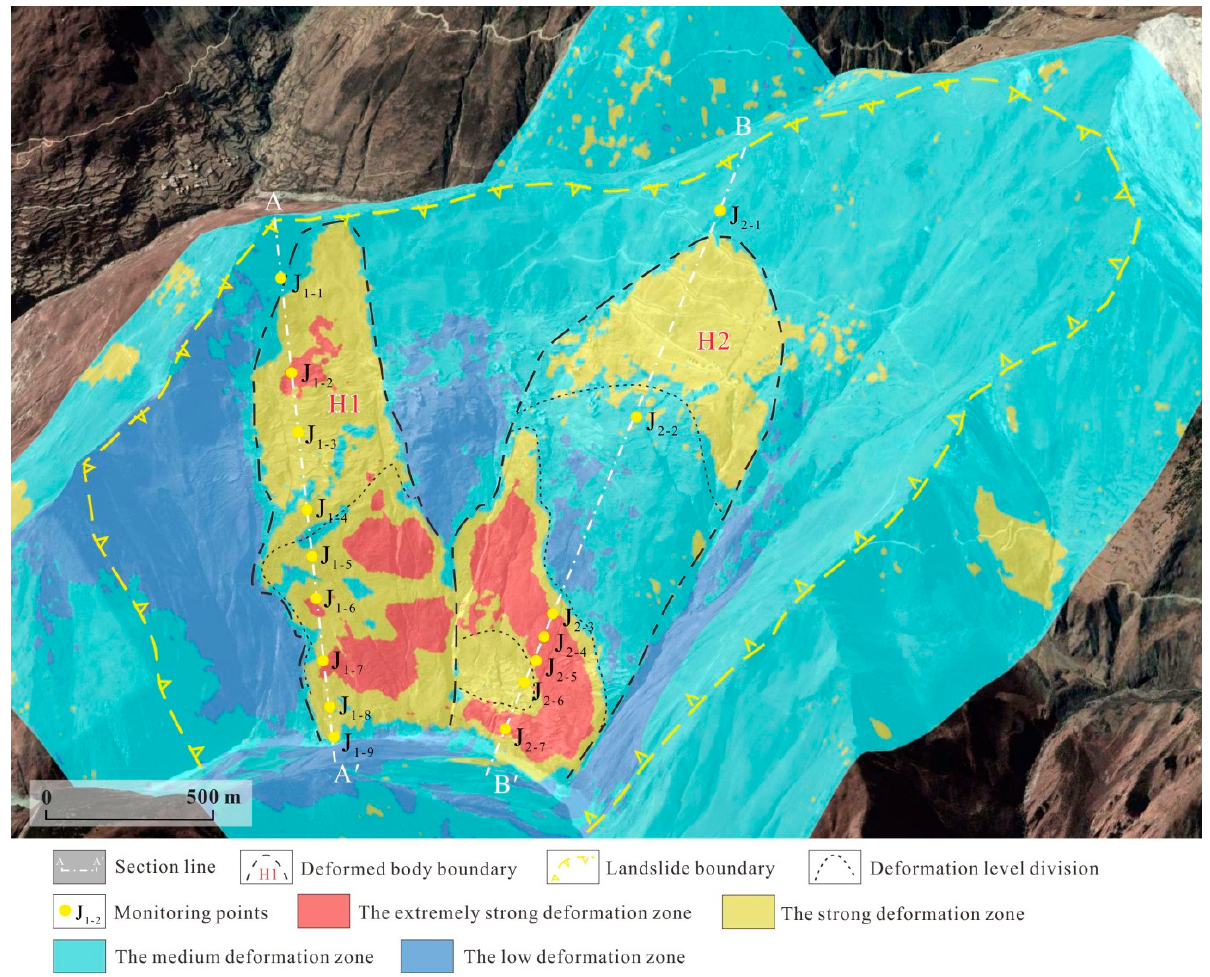
Figure 8. Map of InSAR deformation characteristics of the Xiongba landslide.